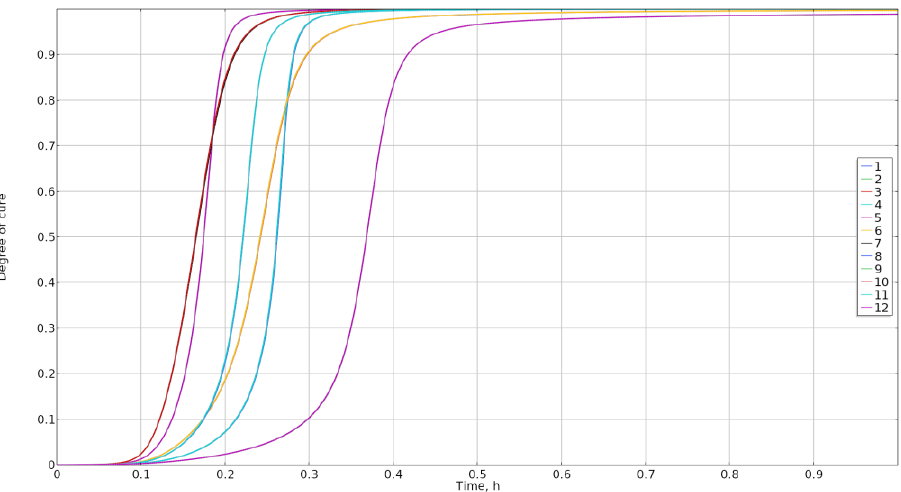
Fig. 3. The degree of cure of the workpiece in the operating area of the microwave heating equipment at times 0.125 (a), 0.250 (b), 0.500 (c) and 1.000 (d) hour.